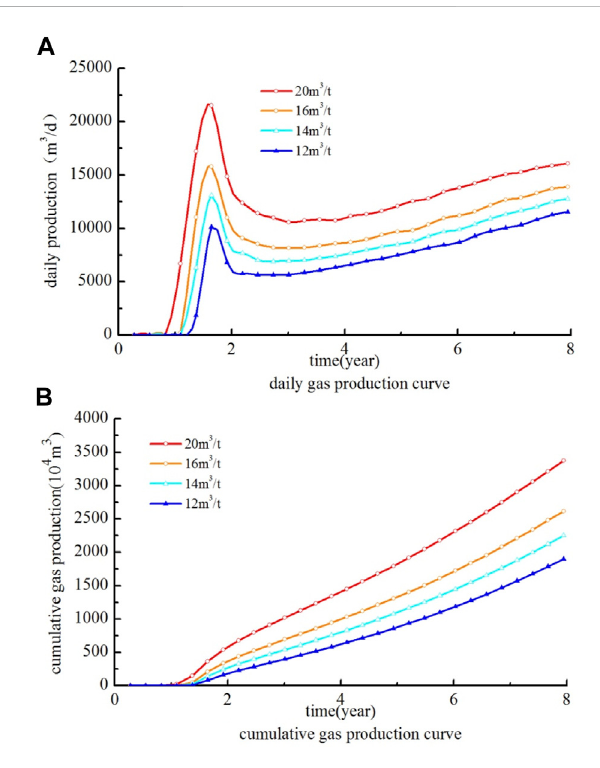
FIGURE 5 Variation curve of gas production with gas content. (A) daily gas production curve, (B) cumulative gas production.